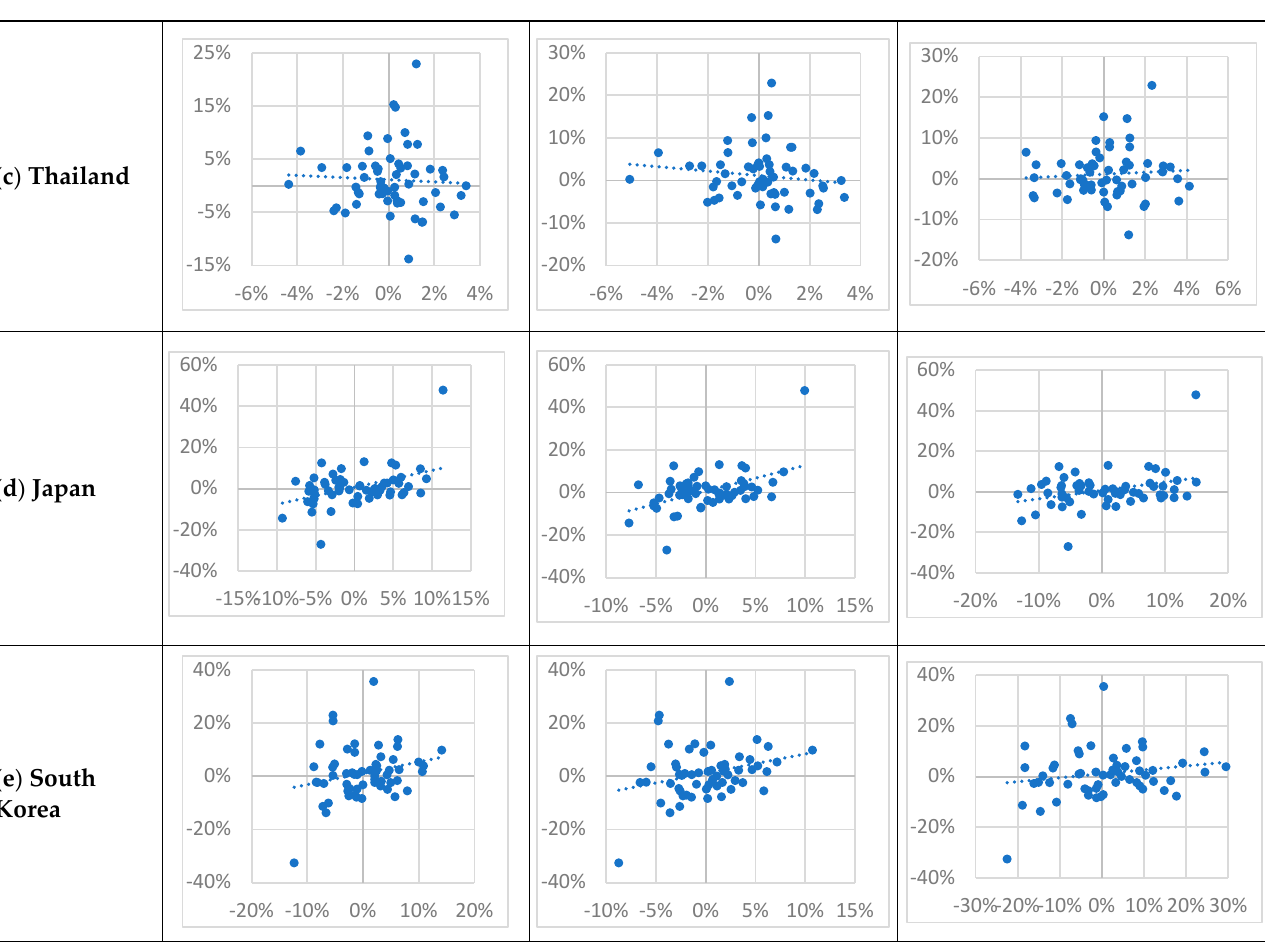
Figure 10. Relationship between change in air temperatures (annual mean, annual maximum, annual minimum air temperature), and change in annual rice yield in ( a ) Vietnam, ( b ) Indonesia, ( c ) Thailand, ( d ) Japan, and ( e ) South Korea. These data range from 1961 to 2020. The X-axis represents the temperature change (%), and the Y-axis represents the yield change (%). (Source: data retrieved from [4,84]).